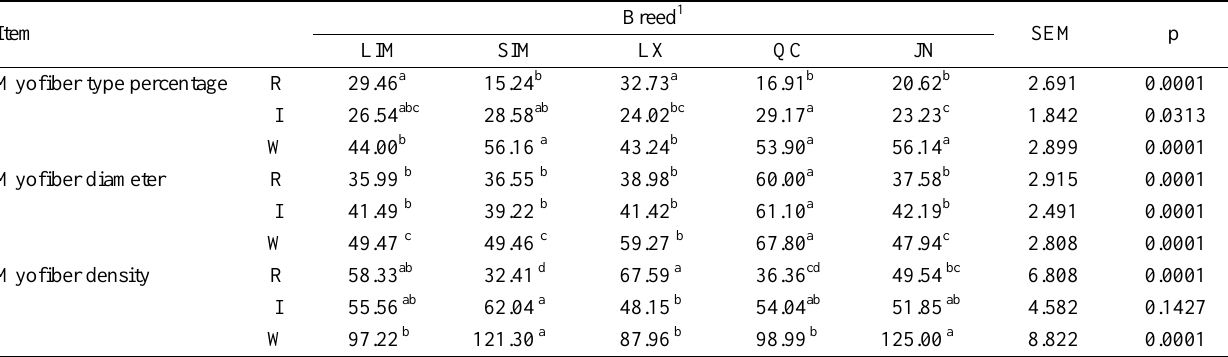
Table 3. Comparison of histological characteristics of muscle fiber of the five cattle breeds Item